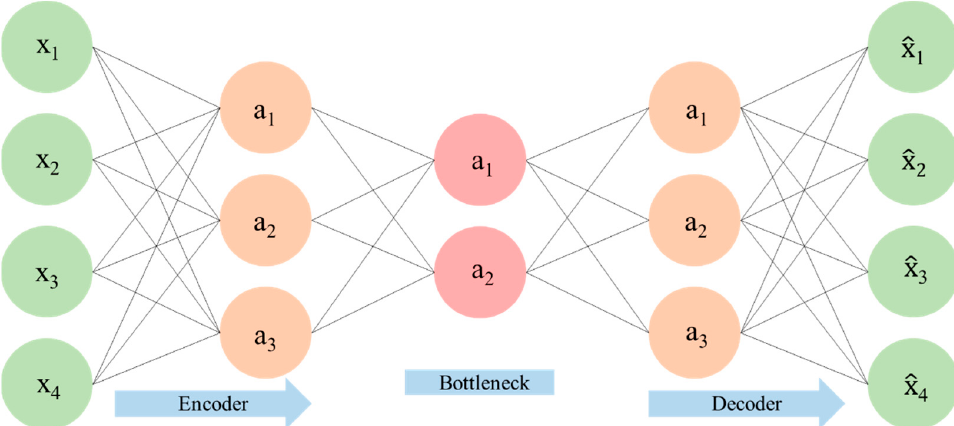
Figure 4 . General structure of an AE, where the encoder part learns meaningful features from the input data, while the decoder reconstructs the original data from these features.